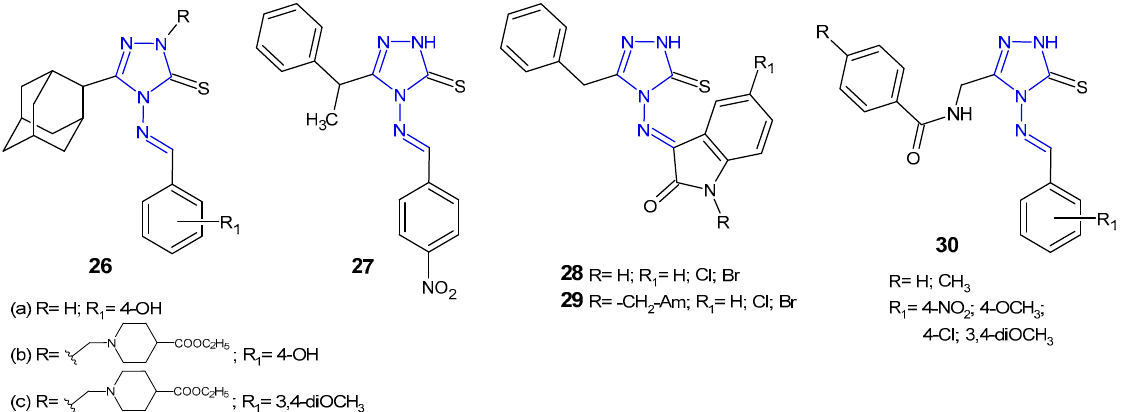
Figure 11. Antibacterial Schiff bases of 1,2,4-triazole.